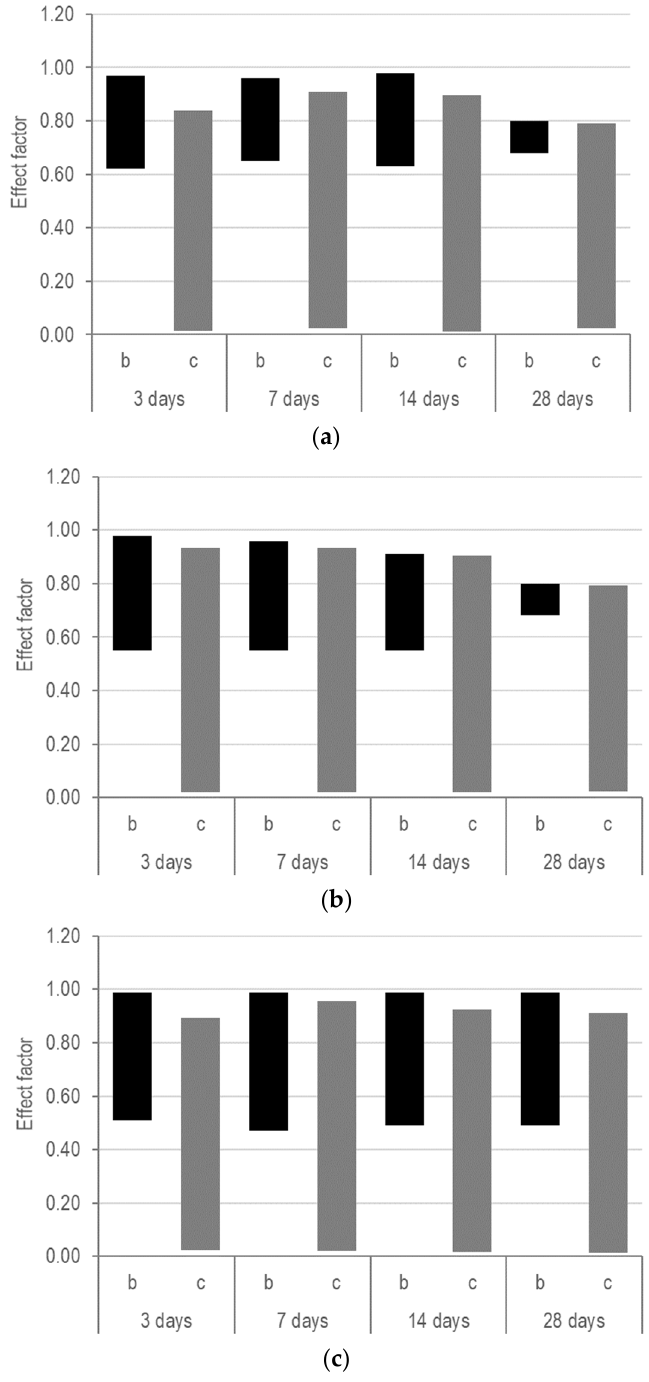
Figure 11. Common ranges of the effect factors for the ( a ) W170, ( b ) W160, and ( c ) W150 mixtures at different ages ( a > b > c , a = 1).